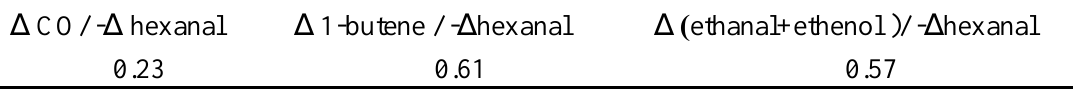
Table 2. Relative yields of different products in typical n -hexanal photolysis experiment, TL/12 lamps (done by quantifying n -hexanal using UV measurement of it) ∆ CO/ - ∆